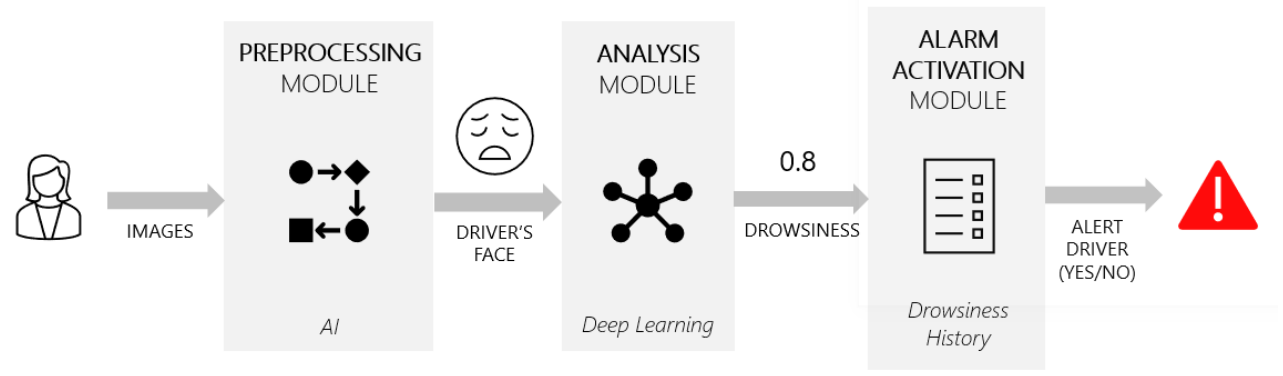
Figure 2. Alternative I